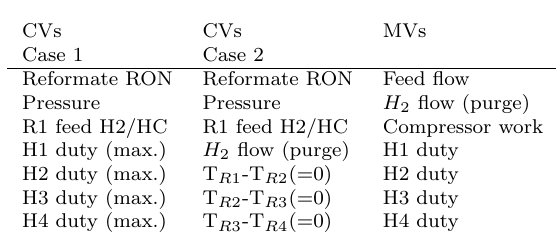
Table 10: Proposed controlled variablesfor the two